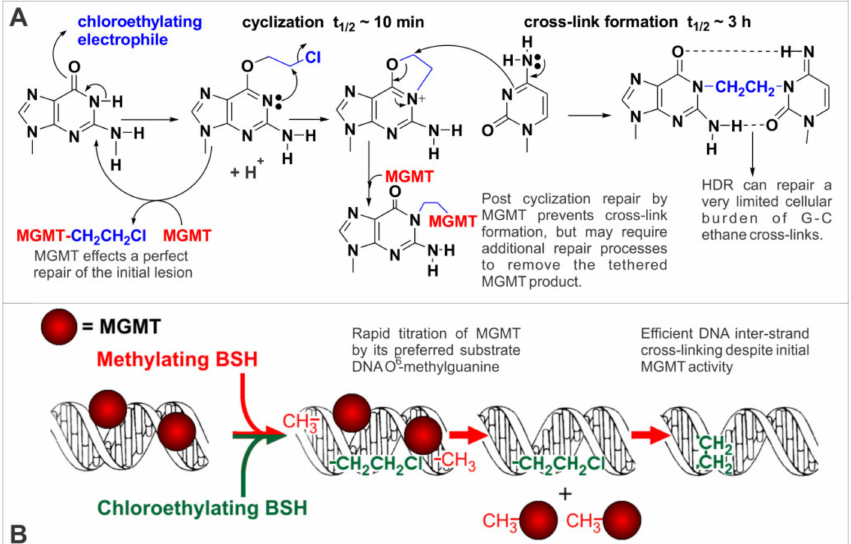
Figure 2. Chloroethylation of the O -6 position of DNA guanine, its sequelae, and the synergistic cytotoxicity of guanine O -6 methylating and chloroethylating BSHs. ( A ) Chloroethylation of guanine O -6 results in the formation of O 6 -(2-chloroethyl)guanine which rapidly rearranges to form the N1, O 6 - ethanoguanine cross-link precursor; this lesion then slowly transitions into highly cytotoxic G-C ethane cross-links. Points of repair/cross-link precursor quenching by MGMT are indicated. A limited number of G-C ethane cross-links can be repaired via HDR. Tumor selectivity arises predominantly from tumor deficits in one or more of these repair processes, with MGMT insufficiency likely being the foremost factor in most cases. ( B ) The synergistic cytotoxicity of guanine O -6 methylating and chloroethylating agents arises from the rapid titration of protective MGMT by the relatively low toxicity O 6 -methylguanine lesion, leaving an unimpaired path for the O 6 -(2-chloroethyl)guanine lesion to progress to highly cytotoxic G-C ethane